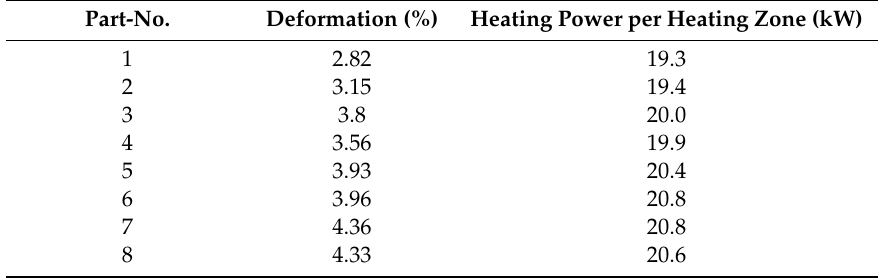
Table 8. Deformation and correlation with constant heating power per heating zone for eight subsequently di ff usion-bonded parts of identical